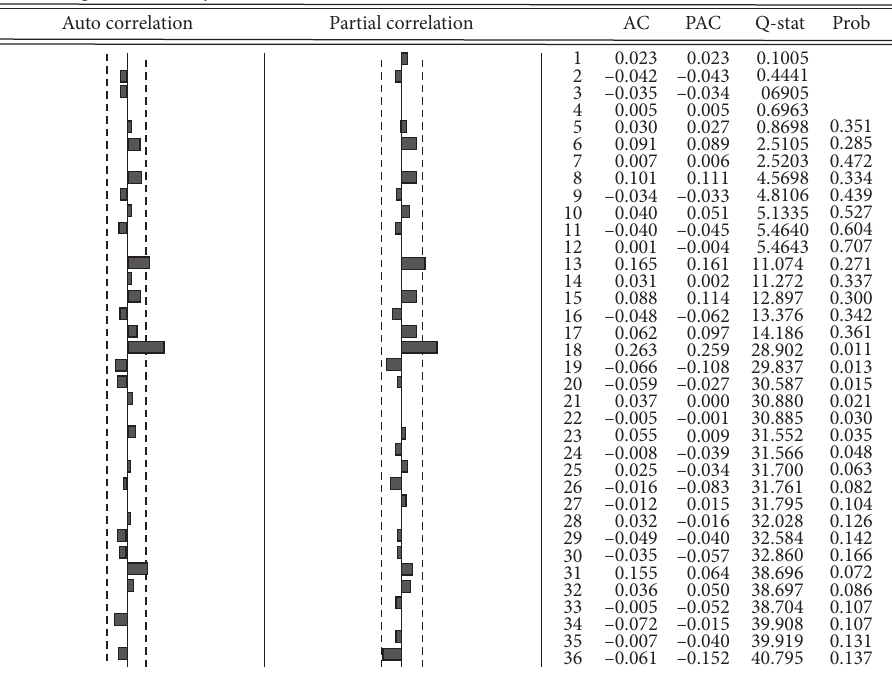
Figure 2: ARCH effect test using Ljung–Box test for squared residuals of the fitted volatility model for silver.